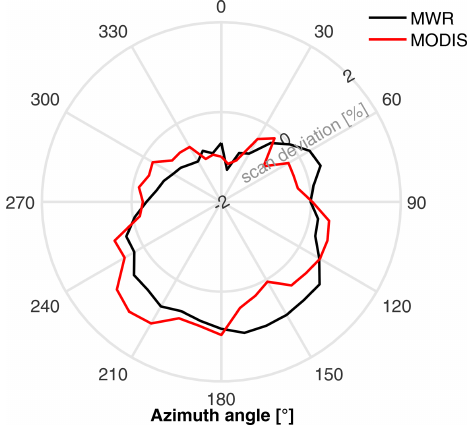
Figure 4. Mean values of the MWR and MODIS water vapor de- viation for the 25 July 2012 case study including five MWR scans (09:10–11:10UTC) and one MODIS overpass at